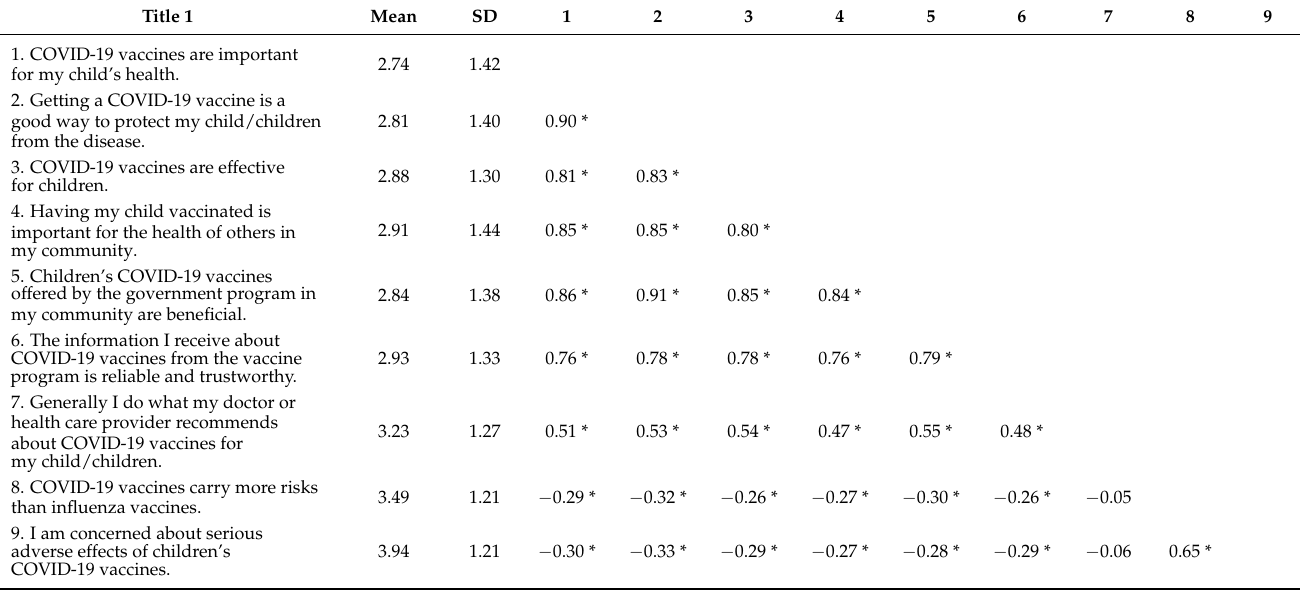
Table 2. Means, standard deviations, and correlations for children-oriented COVID-19 vaccine hesitancy